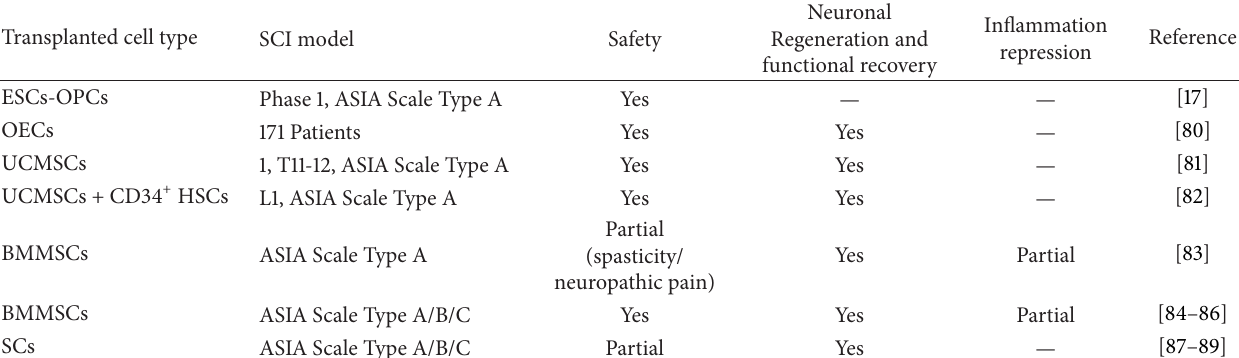
Table 6: Clinical spinal cord injury trials using cell therapy.